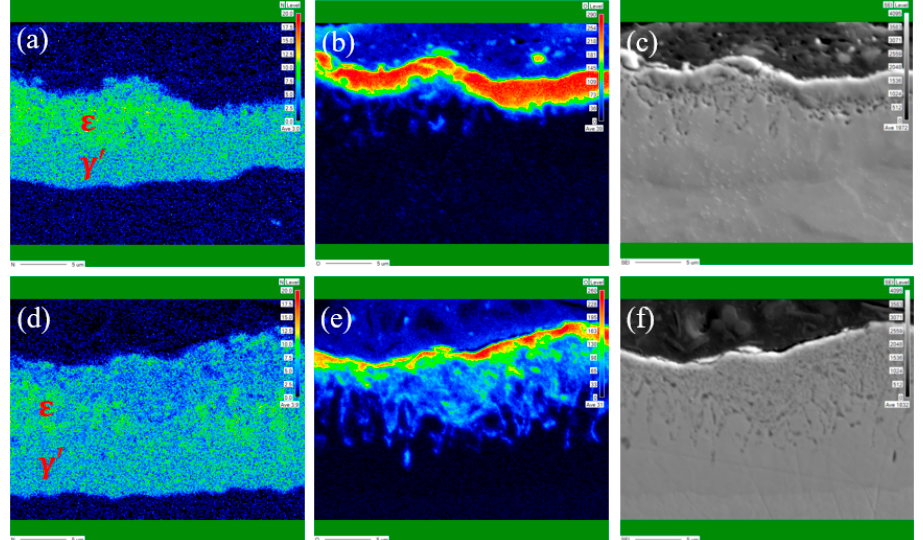
Figure 3. EPMA results for surface hardened layer: ( a ) element map of N, ( b ) element map of O and ( c ) SEM image of the air-specimen, ( d ) element map of N, ( e ) element map of O and ( f ) SEM image of the steam-specimen.